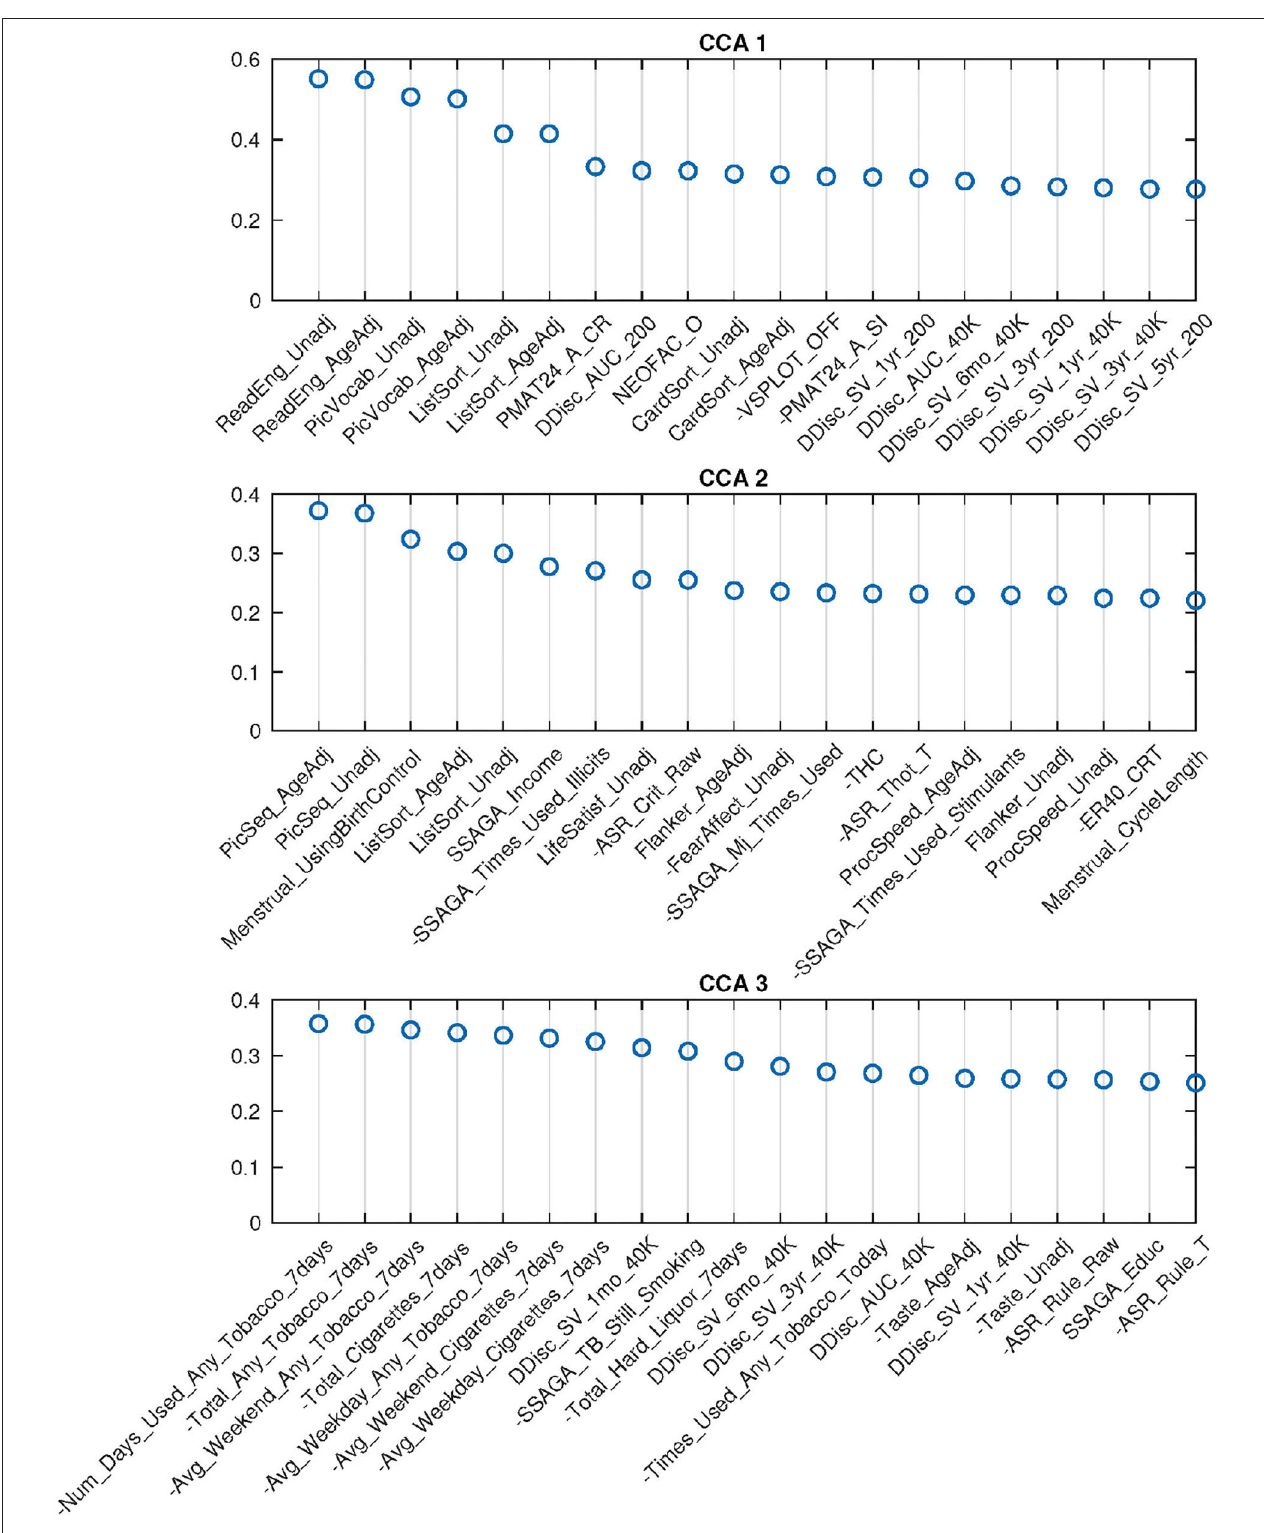
FIGURE 5 | Top 20 SM canonical loadings for 3 significant canonical variables. Variable name with “-” sign shows that it was flipped in the original dataset. Canonical loadings of CCA 1 are very similar to the first set of PCA CCA, heavily cognition dominated; the second set is mixed with cognition, drug use, etc.; The third set is combination of tobacco use and cognition